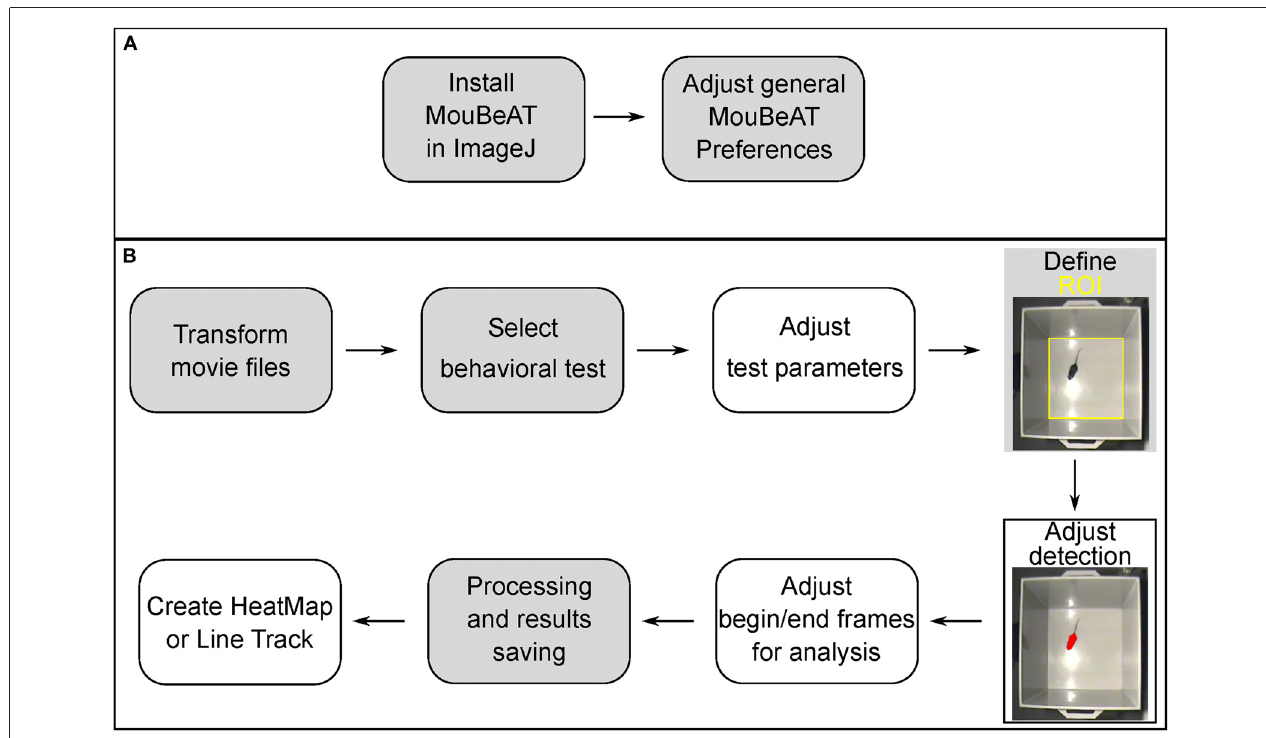
FIGURE 1 | Workflow of Mouse Behavioral Analysis Toolbox (MouBeAT) analysis. (A) Onetime steps of installation and adjustment of general preferences. (B) Main steps for specific tests. Gray filled boxes indicate mandatory steps while empty boxes indicate optional steps. Yellow region of interest (ROI) represent areas created by the user to defined regions of the maze during the workflow in this and all subsequent figures.